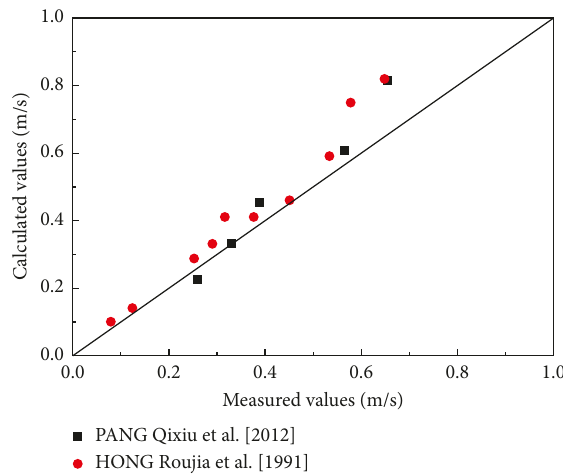
Figure 12: Verification of the empirical formula for incipient velocity of muddy